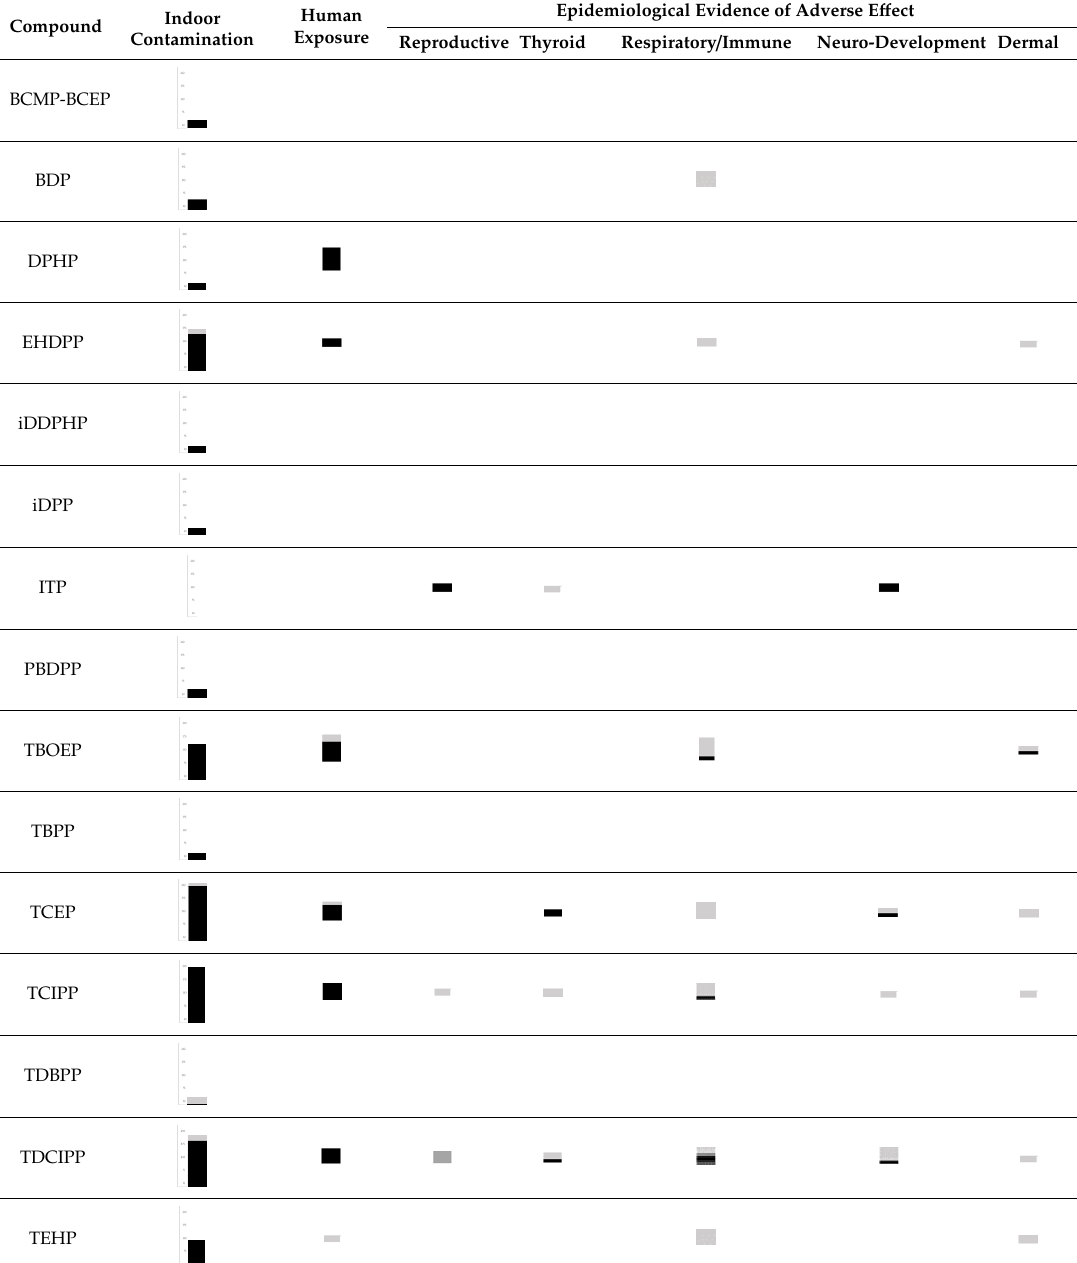
Figure 6. Schematic overview of indoor contamination, human exposure in Europe and epidemiologic evidence of organophosphorus flame retardants. 2000–2019.